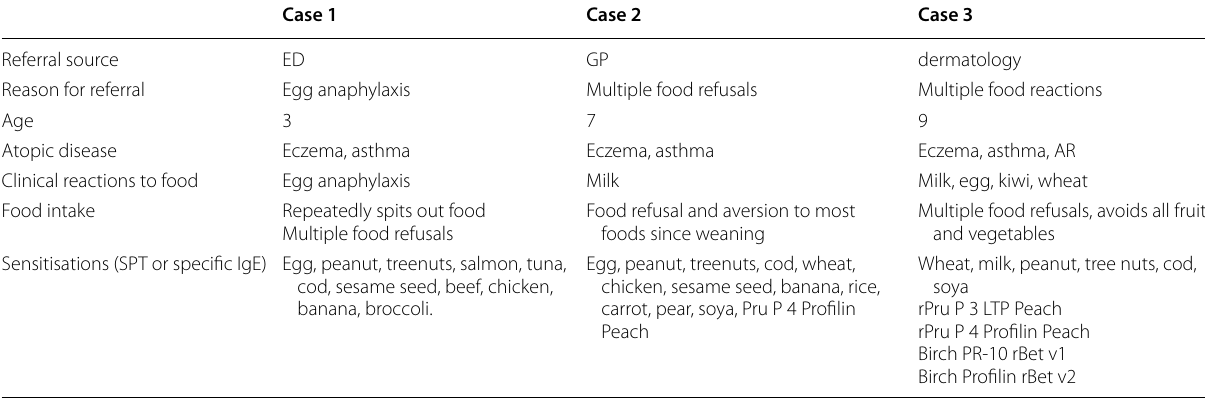
Table 1 Clinical characteristics of 3 children with ASD and confirmed food